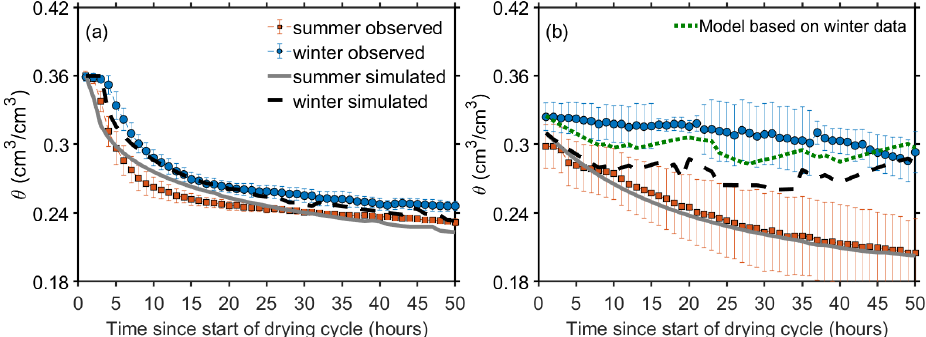
Figure 3. The average and standard deviation values of measured θ at 25cm depth throughout the drying stages at an hourly timescale. (a) Short cycles (station 1) and (b) long cycles (station 2) are shown. The blue and red circles represent the average θ values collected during winter (November–April) and summer (May–October), respectively. The statistics of measured θ under long cycles are based on 19 drying stages during summer and 14 drying stages during winter. For the short cycles, the statistics are based on 12 drying stages during summer and 24 drying stages during winter. The dashed black and solid grey lines represent the average values of simulated θ throughout the drying stage during winter (November–April) and summer (May–October), respectively. Note that, for the long cycle periods, an additional model was established based only on winter data (green